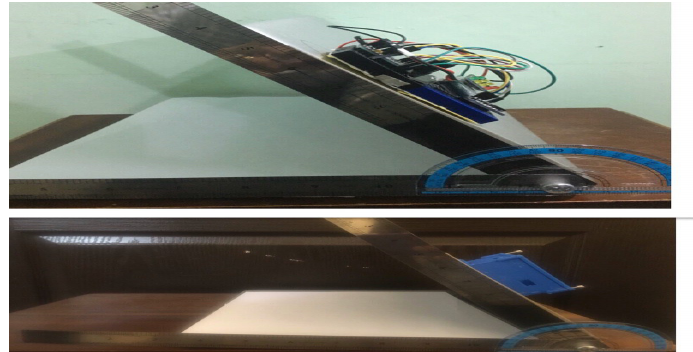
Figure 12. HeadUp device validation using protractor with